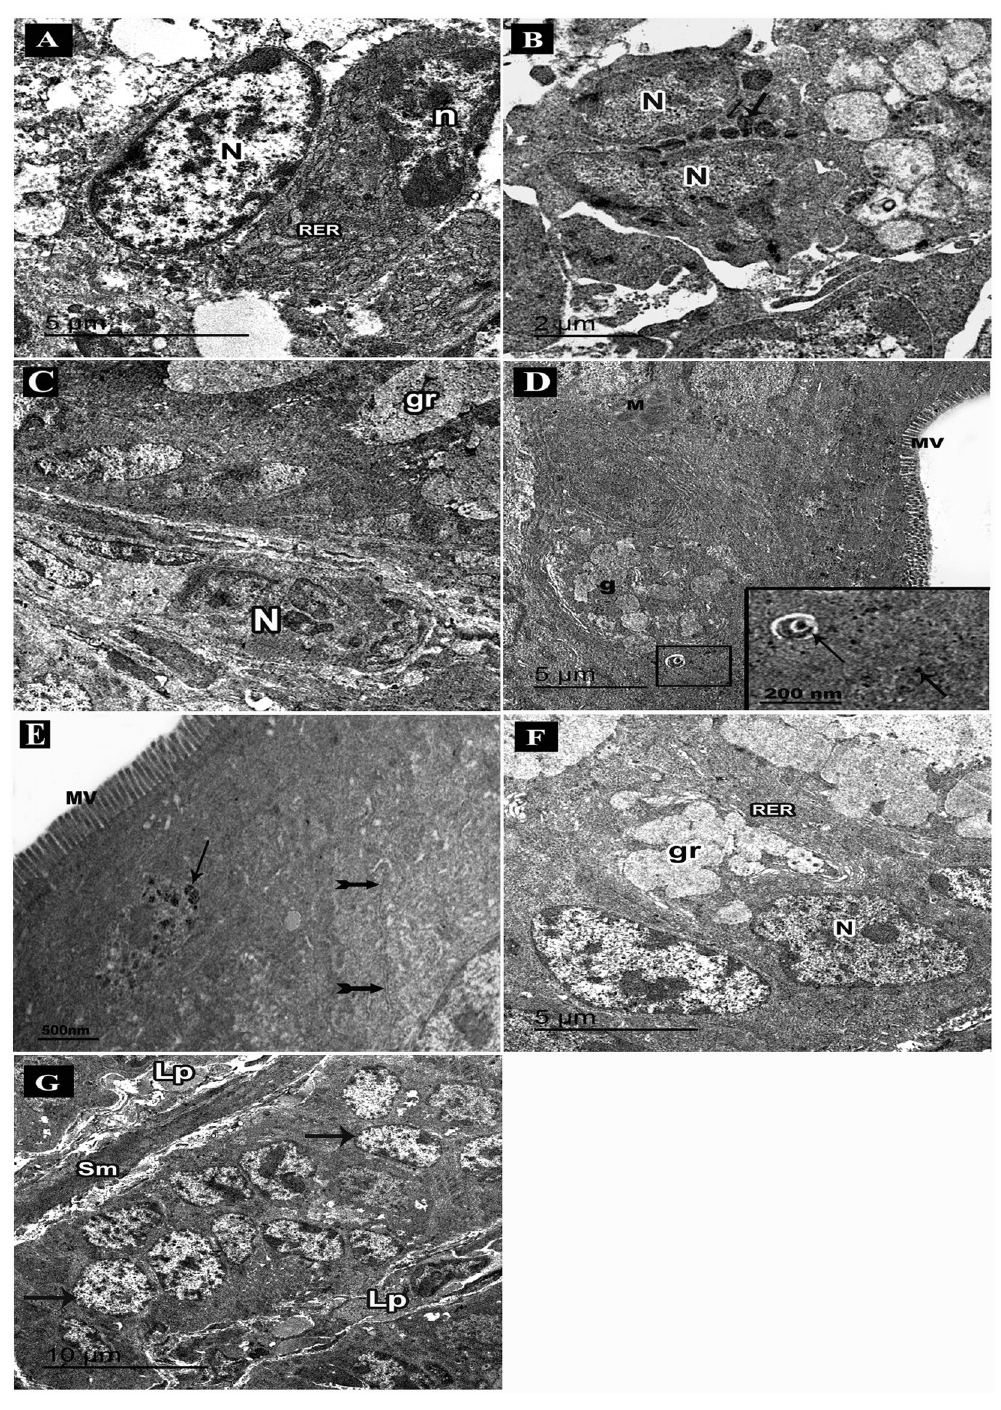
Figure 8. An electron micrograph of ultrathin sections in the colon of adult male mice. ( A–D : DSS group. A ) Intraepithelial infiltrating plasma cell with cartwheel-shaped nucleus (n), rough endoplasmic reticulum (RER), nucleus of columnar cell (N). ( B ) An eosinophil with bilobed nucleus (N) and specific granules (arrows). ( C ) Infiltrating neutrophil with segmented nucleus (N), a goblet cell with mucous granules (gr). ( D – G : DSS + AuNPs group. D ) Columnar cells with abundant microvilli (MV) and mitochondria (M), a part of goblet cell (g). An inset: magnification of the boxed part showing electron dense AuNPs (arrows) in the cytoplasm and within a lysosome ( E ) Columnar cells with abundant microvilli (MV), normal cell junction (bifid arrows), a lysosome containing electron dense AuNPs (arrows). ( F ) Goblet cells with mucous granules (gr), abundant rough endoplasmic reticulum (RER) and basal nuclei (N). ( G) Columnar cells (arrows), a thin core of lamina propria (Lp), smooth muscle cells of muscularis mucosa